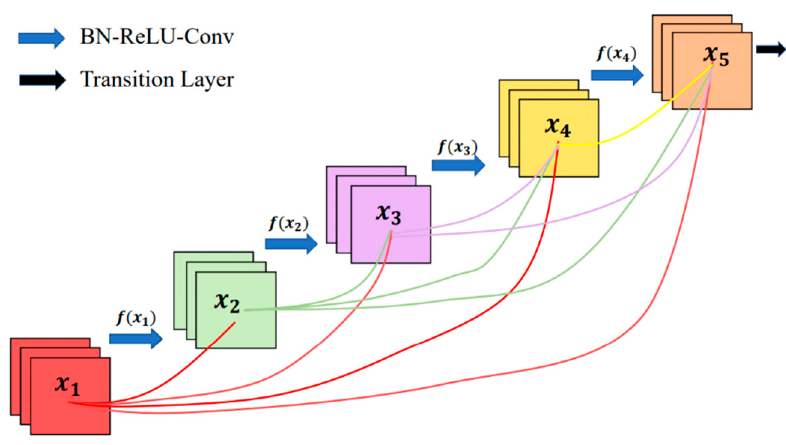
Figure 5. The structure of DenseNet (derived from [42]). DenseNet greatly reduces the number of parameters by using a dense block